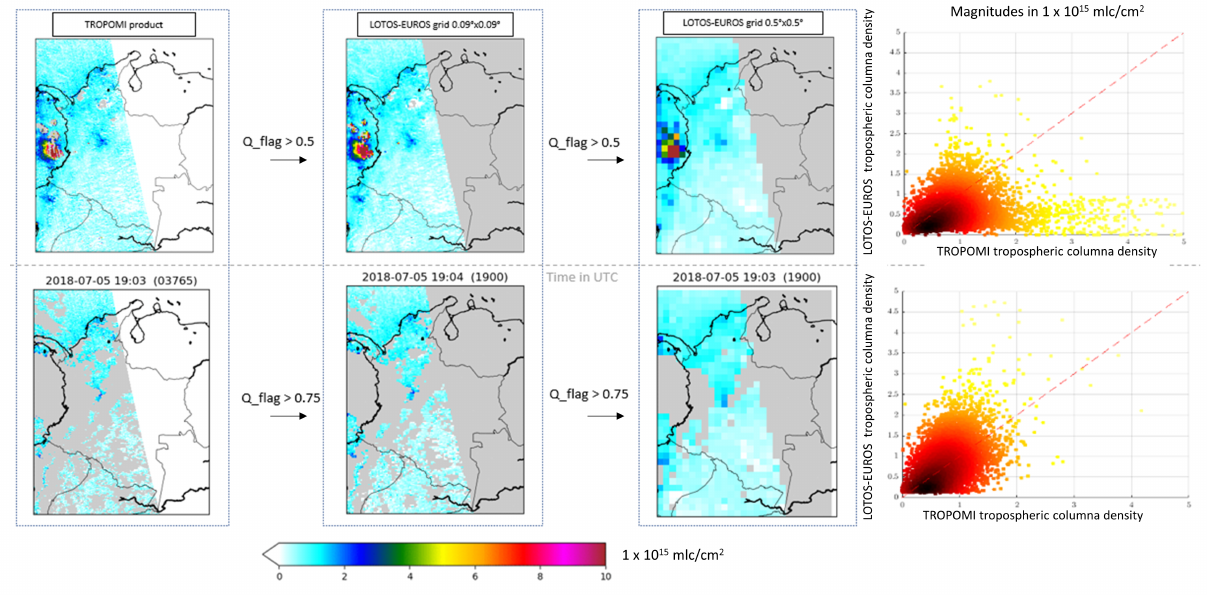
Figure 4. Illustration of the TROPOMI data downloaded before the re-gridding. ( Upper ) Data filtering at quality flag threshold of 0.5. ( Lower ), data filtering at quality flag threshold of 0.75. ( Left column panels ) TROPOMI data retrievals for the two qualitiy flags. ( Center ) TROPOMI data projected to LOTOS-EUROS grids at resolutions of 0.09° ( center ) or 0.5° ( center-right ). ( Right ) Scatter plots at comparing TROPOMI vs. LOTOS-EUROS pixel values for the resolution of